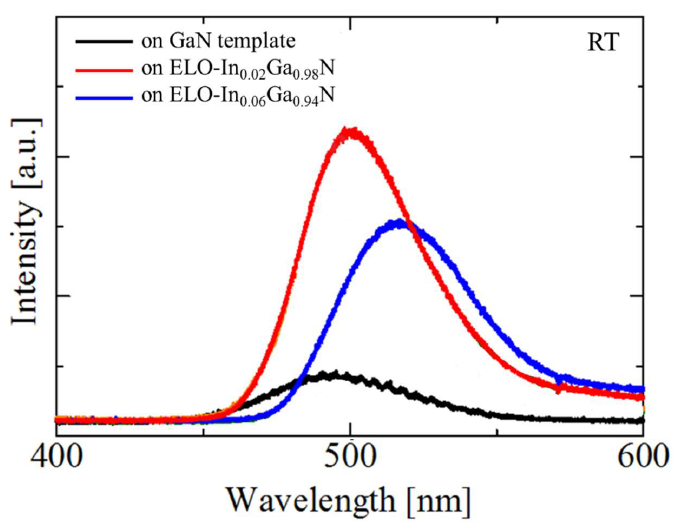
Figure 8. The PL spectra of the {11-22} InGaN/GaN MQWs on the GaN and ELO-InGaN templates.